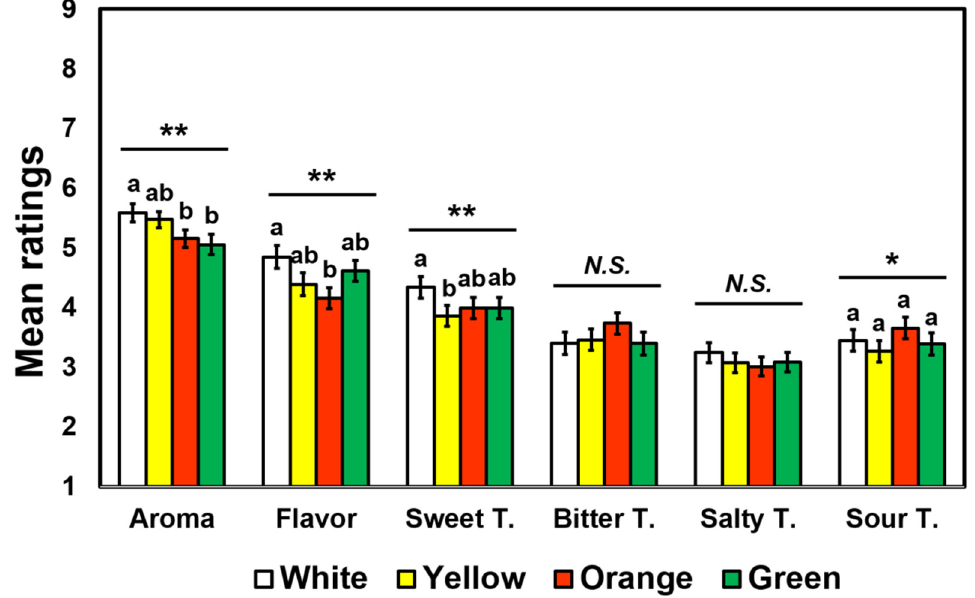
Figure 3. Mean rating comparisons among the four colored cooked-rice samples with respect to intensity ratings of aroma, flavor, sweet taste, bitter taste, salty taste, and sour taste evaluated by 98 participants. Attribute intensities of cooked rice samples were evaluated on 9-point category scales ranging from 1 (extremely weak) to 9 (extremely strong). Error bars represent standard errors of the means. * and ** represent a significant di ff erence at p < 0.05 and p < 0.01, respectively. Mean ratings with di ff erent letters within a category indicate a significant di ff erence determined by post hoc multiple pairwise comparisons Tukey’s Honestly Significant Di ff erence (HSD) tests at p < 0.05. N.S . represents no significant di ff erence at p < 0.05.